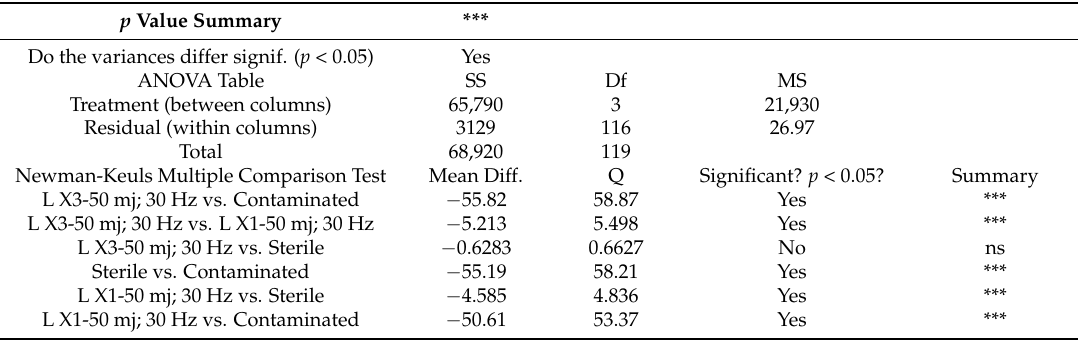
Table 3. Table showing the mean differences and p -values of each of the two tested-group. The difference is significant between all types of groups, except between LX3 and the sterile group. *** means the difference is highly significant (0.1 %).